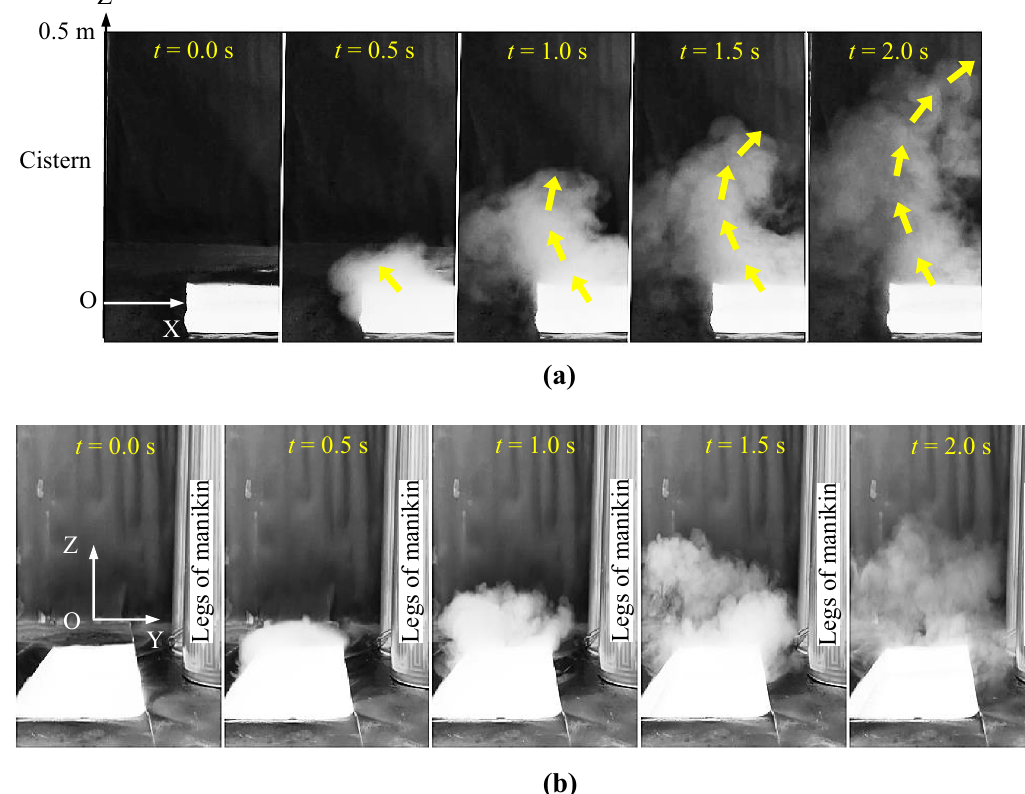
Figure 2. Visualization of transient airflow using water mist as a tracer in the lavatory during flushing: ( a ) lateral view, ( b ) front